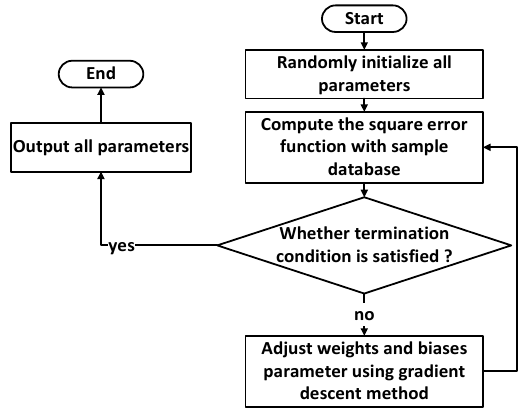
Figure 3. Flow chart of the NN training process using the gradient descent method.